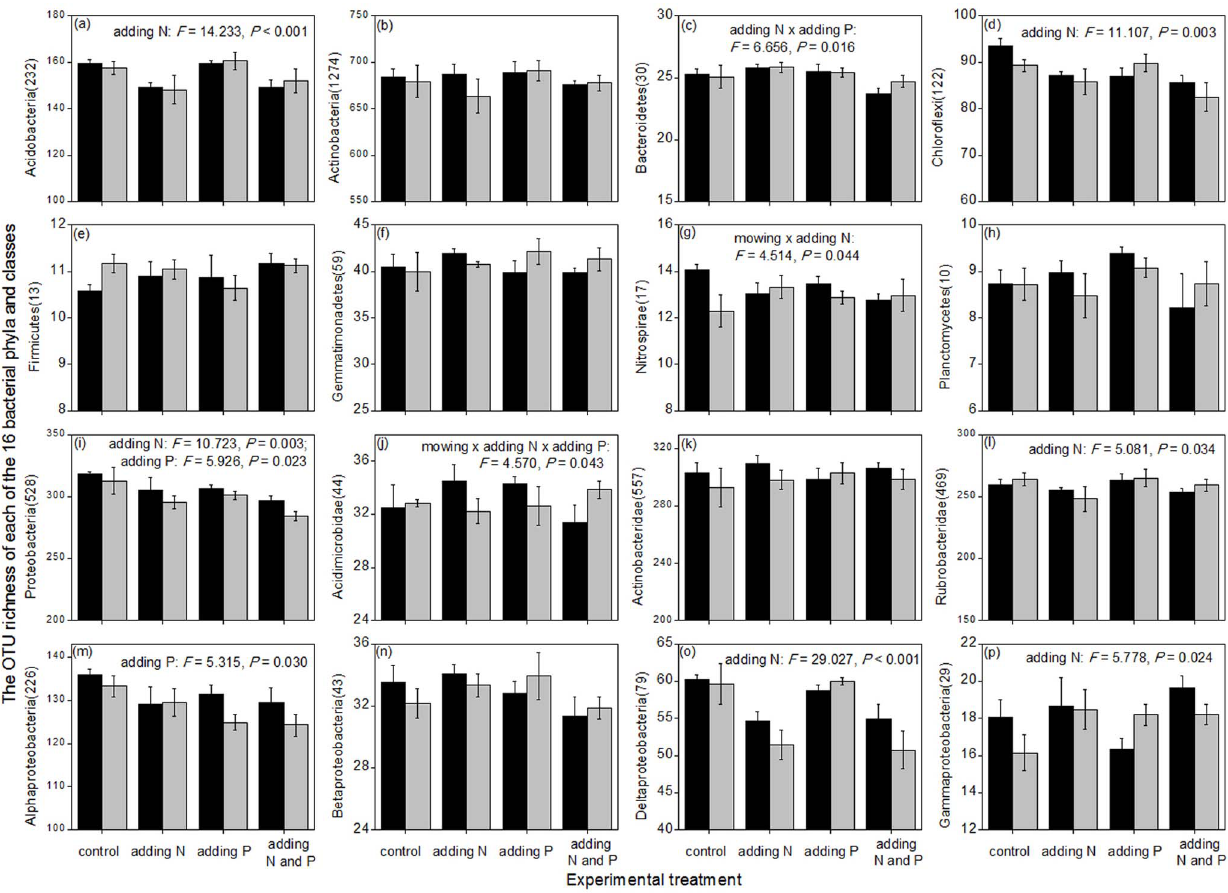
Figure 3. Effects of experimental treatments on the OTU richness of 16 dominant bacterial phyla/classes. Three-way ANOVA was used to test the effect of experimental treatments. For clarity, only the significant statistical results ( P , 0.05) are shown in the figure. The bars represent one standard error (n=4). The black and gray columns represent the treatments without and with mowing, respectively. The number in the brackets following the phylum/class name (e.g., 232 in Acidobacteria(232) in Fig. 3a) represents the sampled sequence number from which OTU richness was calculated.